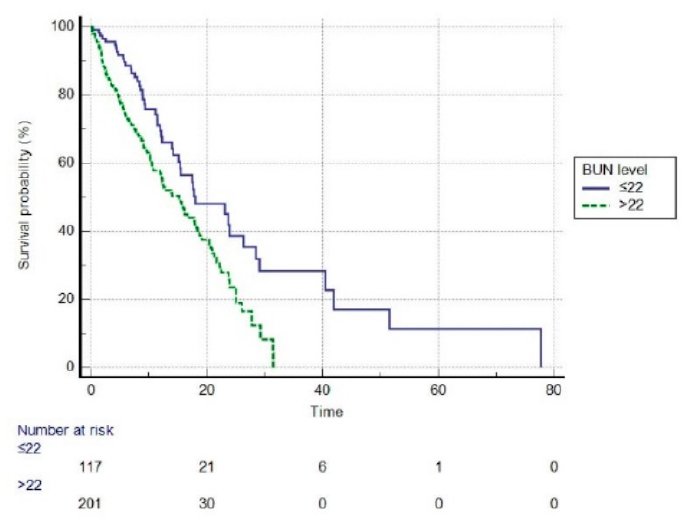
Figure 4. The Kaplan–Meier survival curve of high and low BUN groups (after propensity score matching, log-rank p < 0.001). BUN, blood urea nitrogen